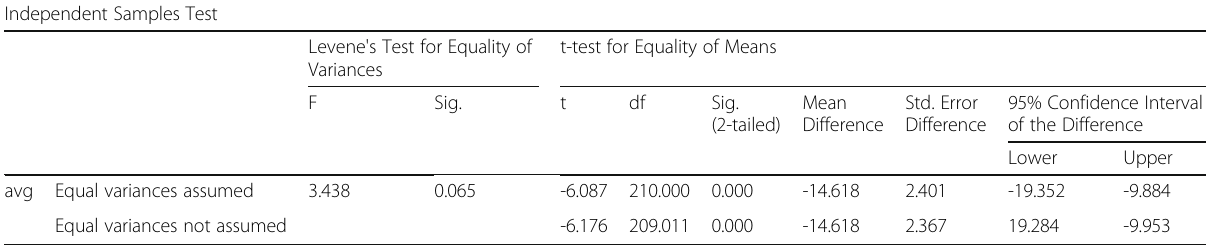
Table 1 Statistical significance verification of age distribution between osteomyelitis patient and control group Independent Samples